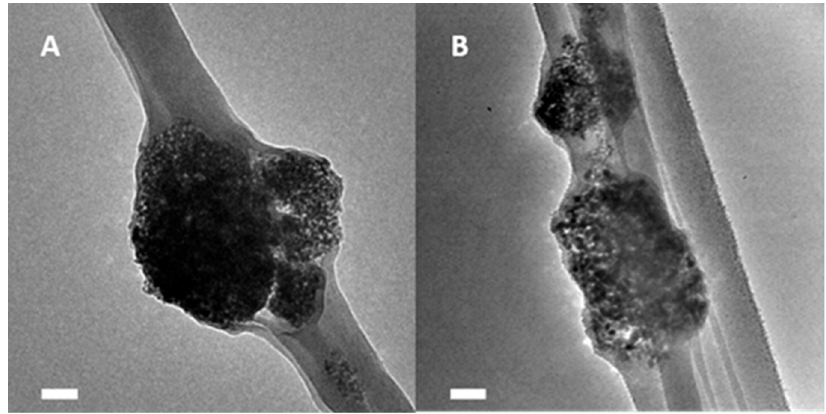
Figure 2. TEM analysis of PAN-Au / TiO 2 and PAN-AuPd / TiO 2 samples ( A , B , respectively). Scale bars: 100 nm.